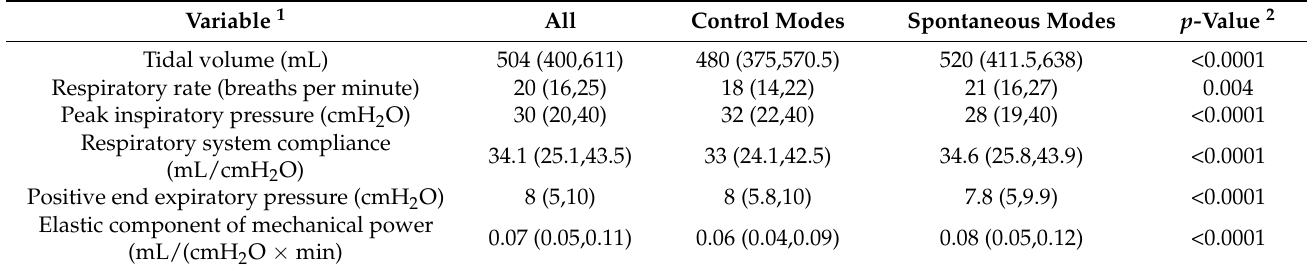
Table 1. Ventilator parameters during the transition from control to support modes.